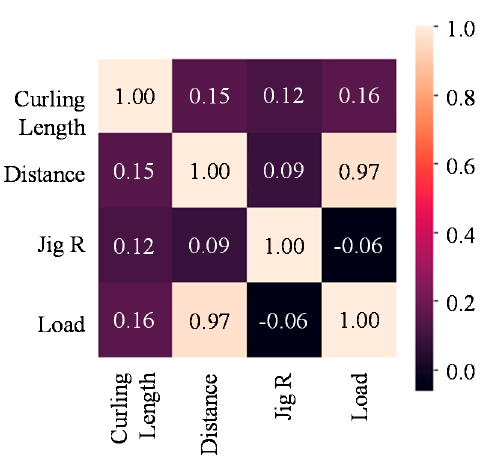
Figure 9. Comparison of correlation between design variables. Table 3. Dataset for sensitivity analysis.